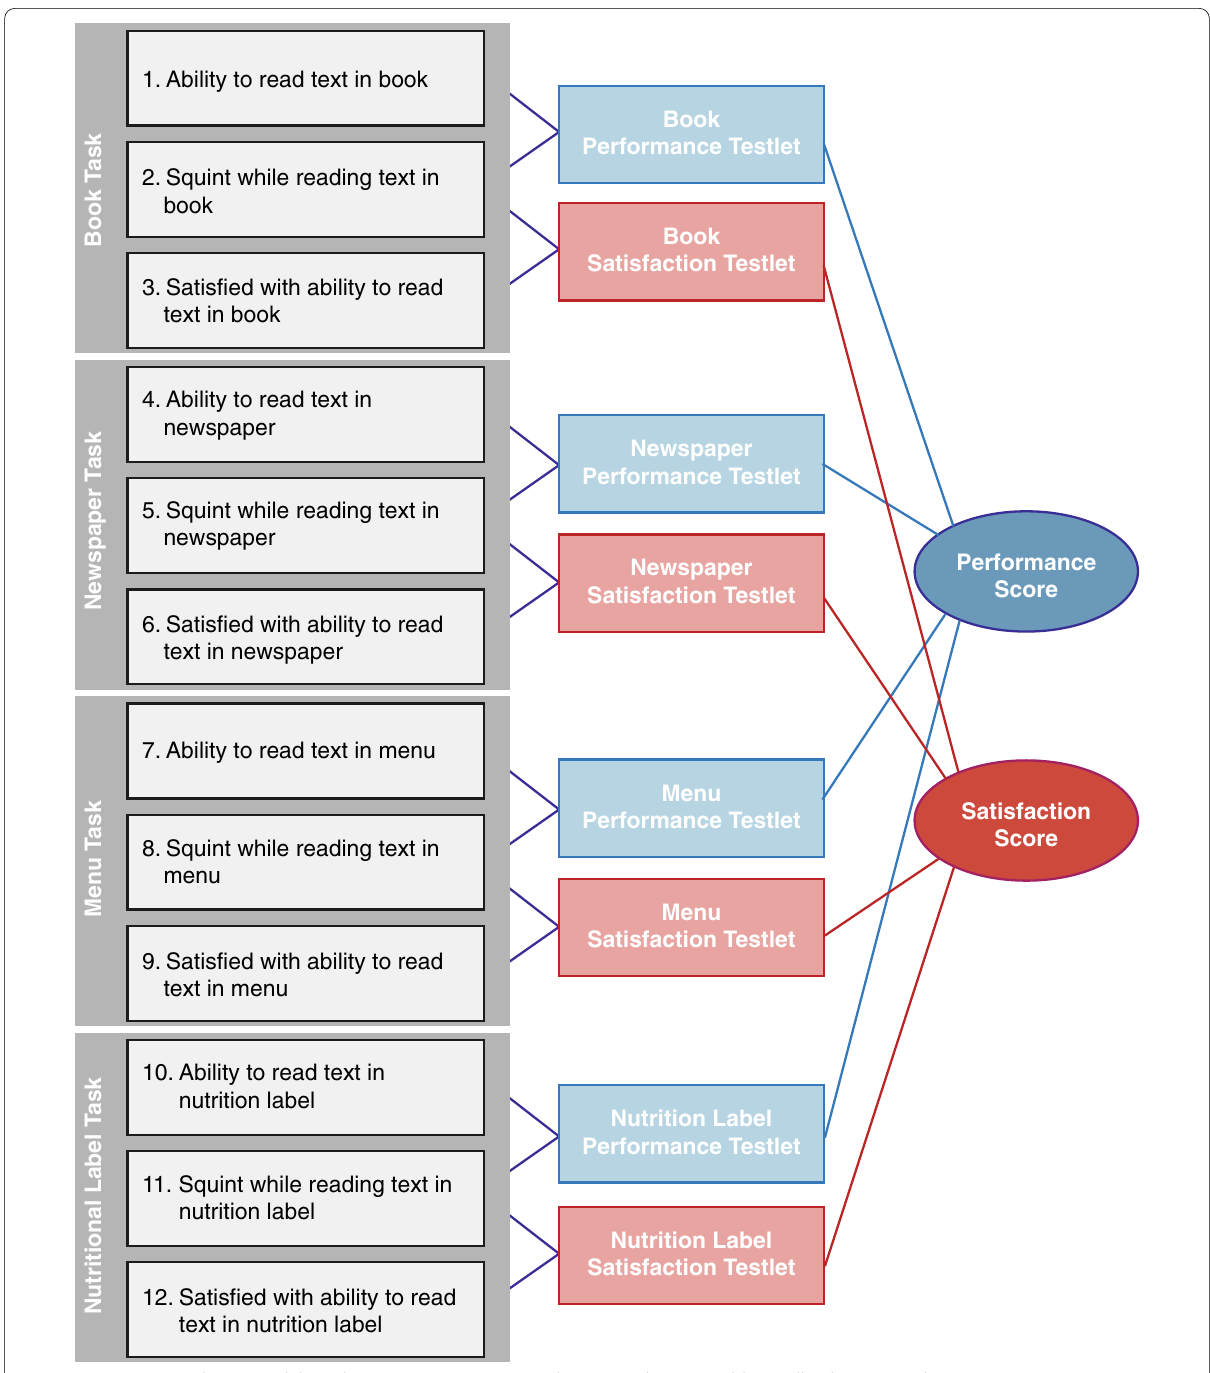
Fig. 5 Near Vision Presbyopia Task-based Questionnaire Conceptual Framework. ©2021 AbbVie. All rights